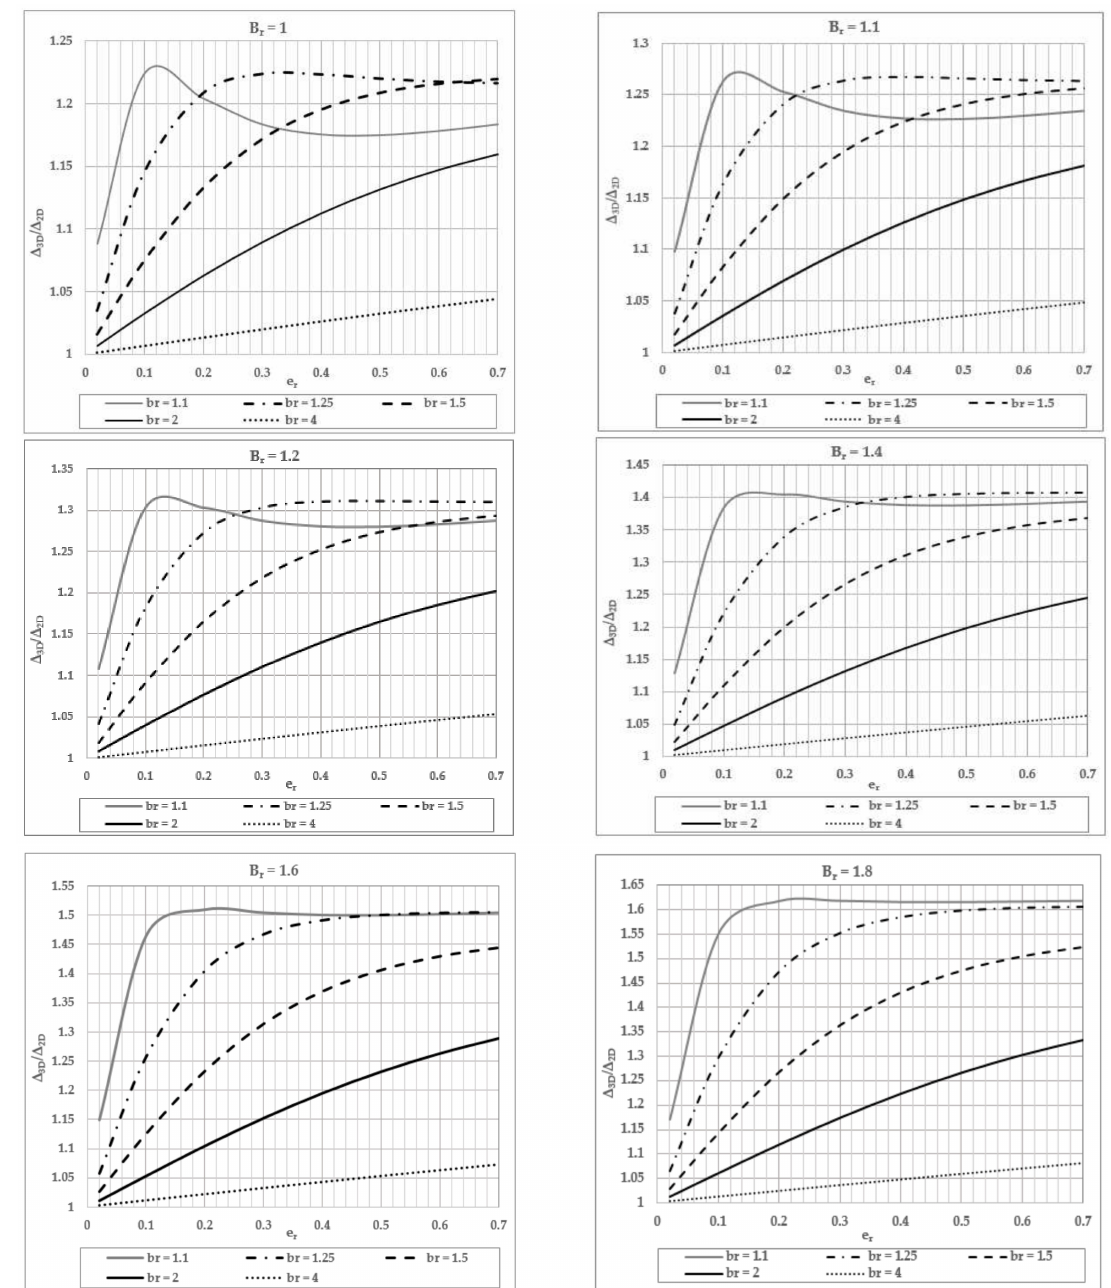
Figure 10. Edge displacement ratio for displacement-controlled condition ( T n 1 > T 2